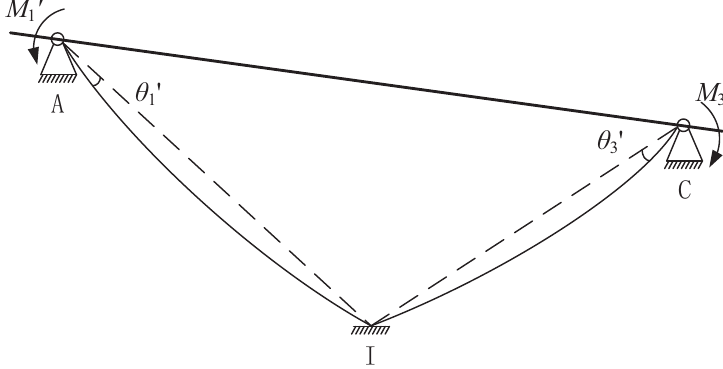
Fig. 3. Loading of the web member.